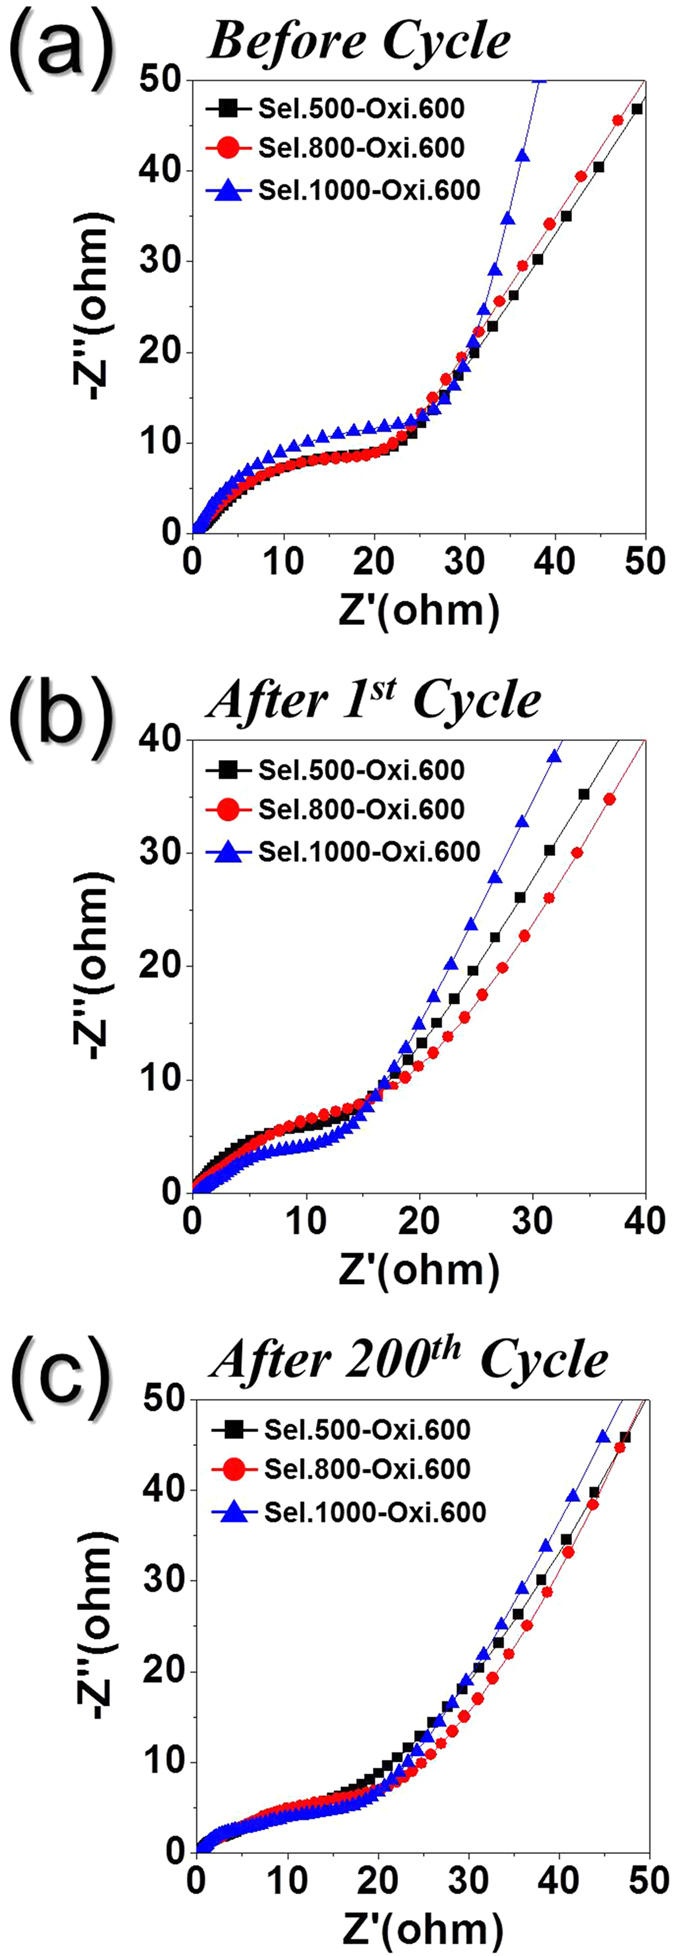
Nyquist impedance plots of the hollow-structured Fe2O3 nanopowders before and after cycling.(a) before cycle, (b) after 1st cycle, and (c) after 200th cycle.